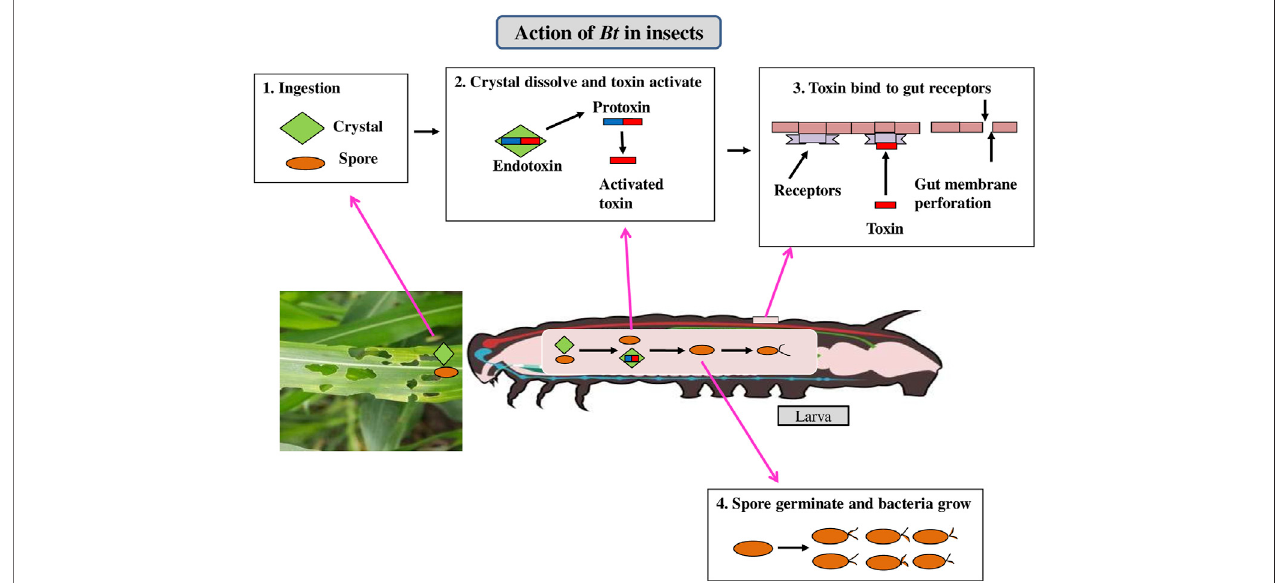
FIGURE 2 | Mechanism of action of Bt cry toxin in